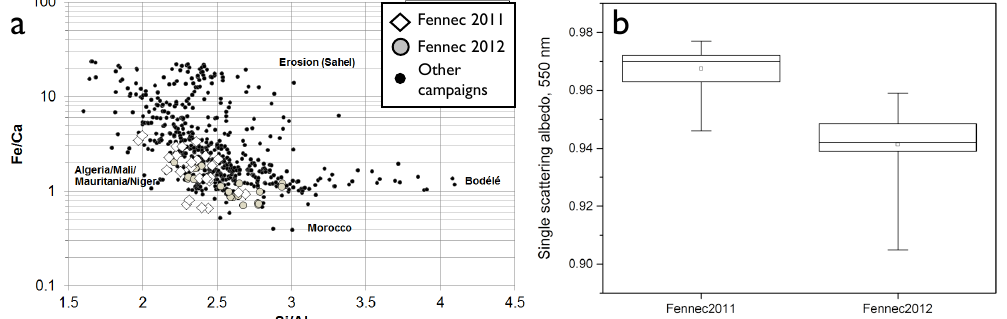
Figure 5. (a) Scatter plot of the elemental Fe / Ca vs. the Si / Al ratios for the Fennec 2011 and 2012 samples compared to samples collected during the AMMA, DODO and GERBILS campaigns (Formenti et al., 2014). Indications of the source regions according to the values of those tracers are also given. (b) Box plot of SSAs at 550nm measured during Fennec 2011 and 2012 for horizontal runs corresponding to filter samples taken. SSAs are calculated from scattering measured by the nephelometer and absorption measured by the PSAP on the BAe146 mounted behind Rosemount inlets, and therefore represent accumulation mode only. Box lines represent the median and interquartile range, whiskers represent the minimum and maximum values and the squares represent the